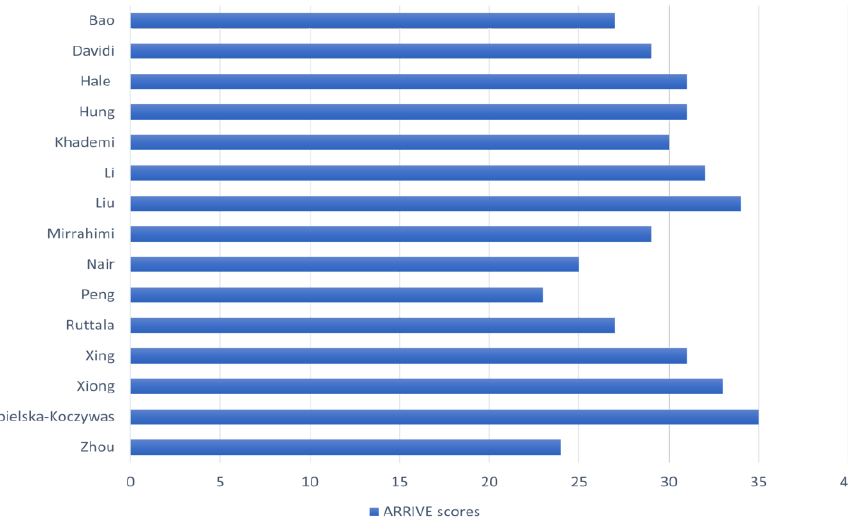
Figure 2. ARRIVE (Animal Research Reporting of In Vivo Experiments)